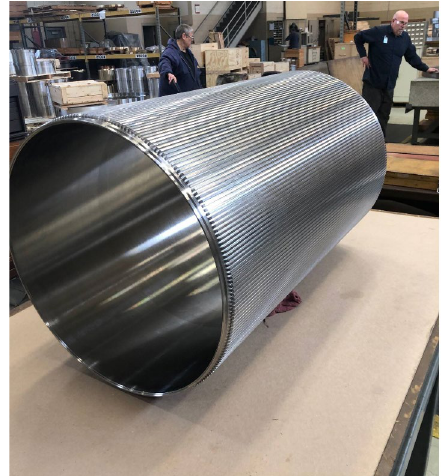
Fig. 11 . Stainless steel inner cylinder